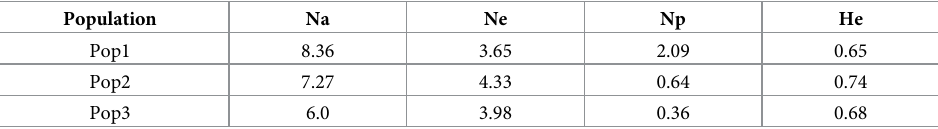
Table 3. Allelic pattern of MHC loci among populations (Pop1, Pop2, Pop3). Population Na Ne